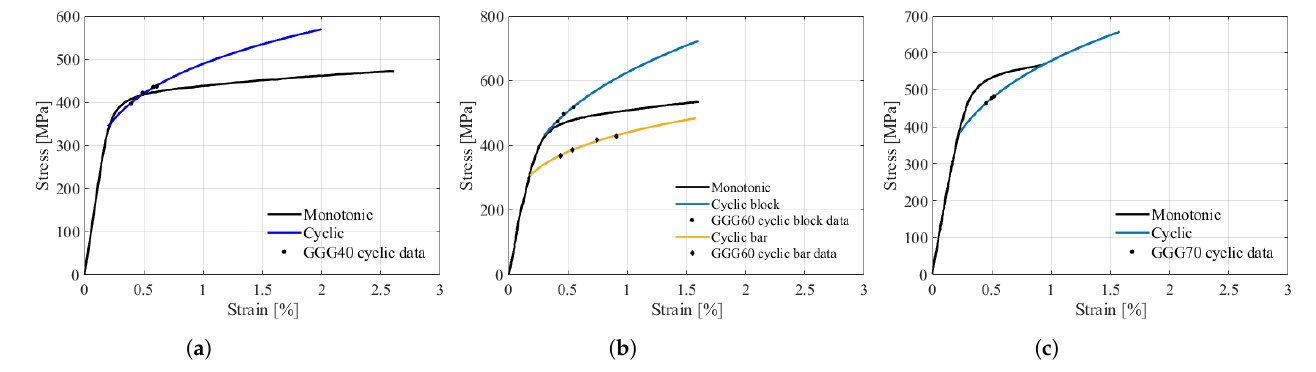
Figure 7. Cyclic and monotonic stress-strain curve for ( a ) GGG40 ( b ) GGG60 ( c ) GGG70.